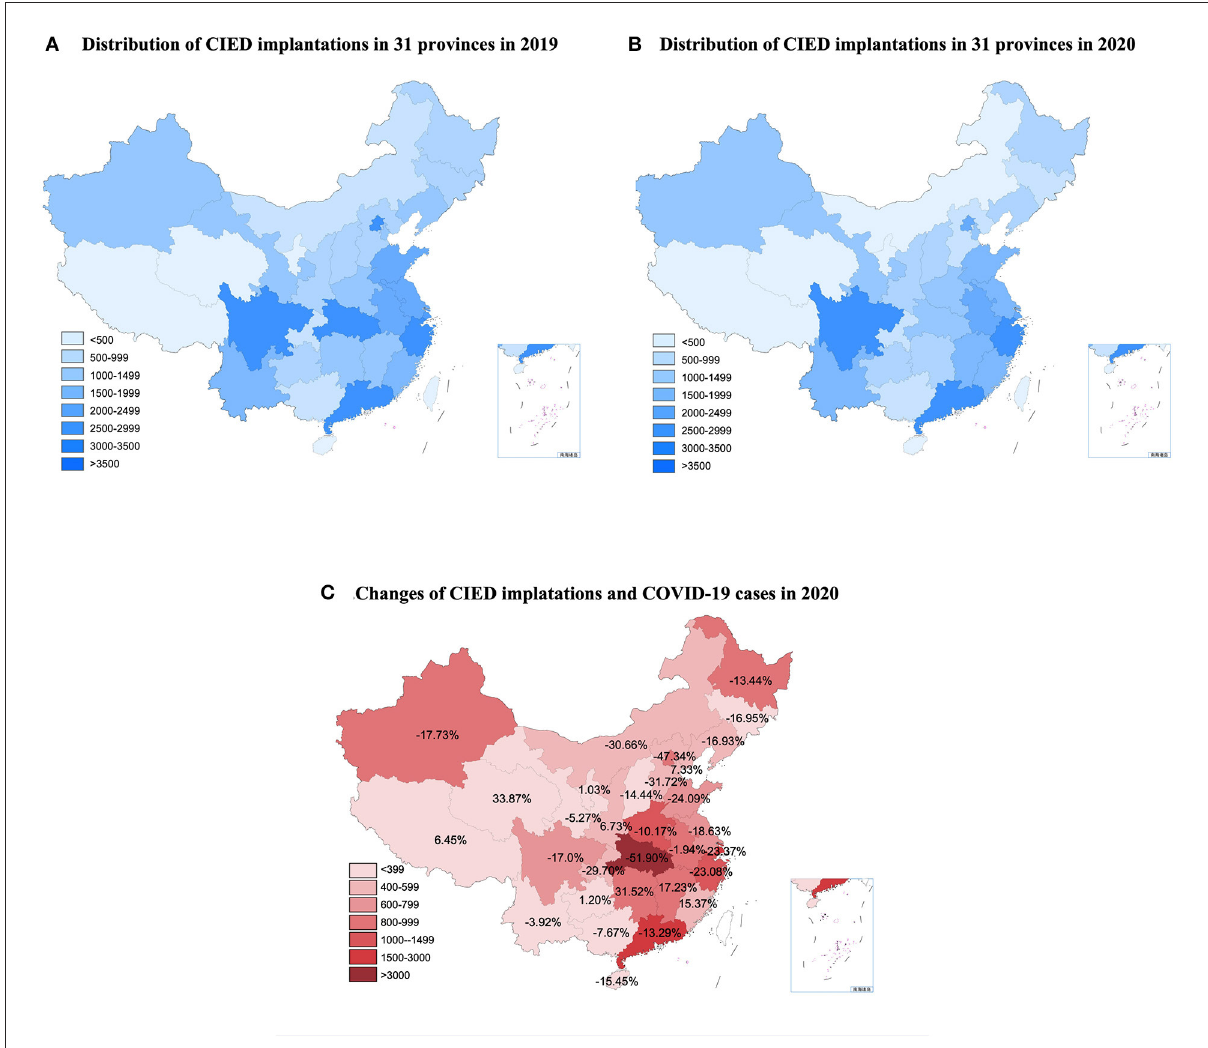
FIGURE3 The distribution of CIED implantations in the pre-COVID period and 2020 and the relationship between changes and COVID-19 cases. CIED, cardiac implantable electronic device; COVID-19, Coronavirus disease 2019. (A) Distribution of CIED implantations in 31 provinces in 2019. (B) Distribution of CIED implantations in 31 provinces in 2020. (C) Changes of CIED implantations and COVID-19 cases in